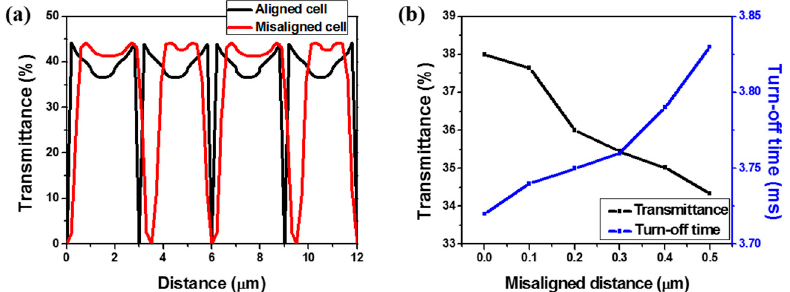
Figure 8. The effect of misalignment between the top and bottom patterned electrodes. ( a ) Transmittance distributions in an aligned cell and a cell misaligned by 0.5 μ m; ( b ) Transmittance and turn-off time of PVA cells as functions of misalignment.